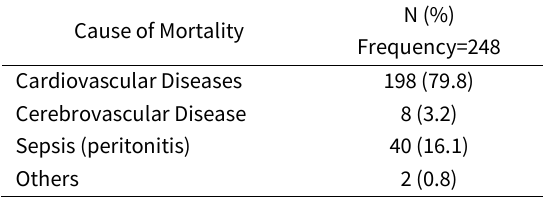
Table 3 . Bacteria that cause peritonitis in CAPD Patients Causes Peritonitis